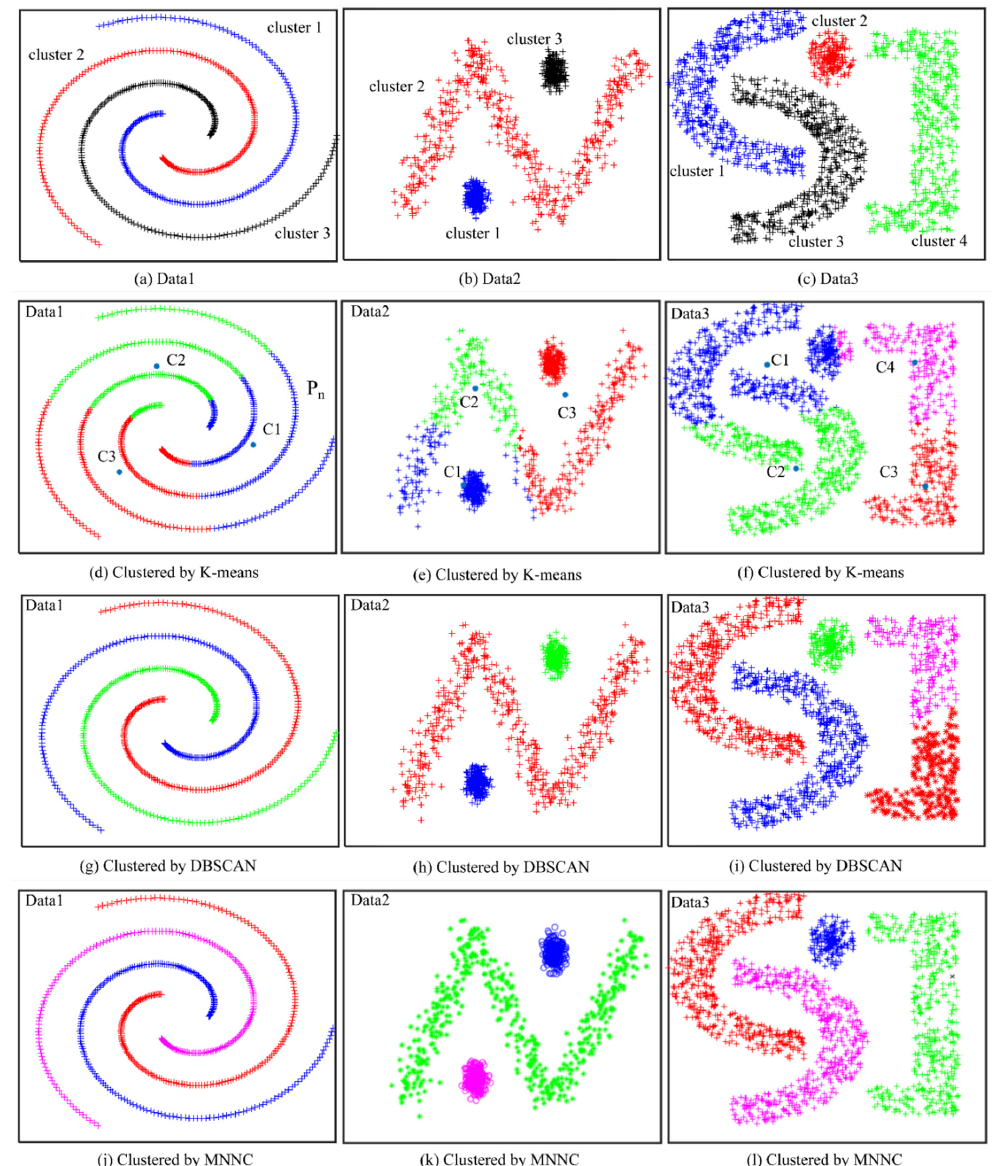
Figure 5. Clustering results of different clustering algorithms: ( a – c ) are the reference results; ( d – f ) are clustered by k-means; ( g – i ) are clustered by DBSCAN; ( j – l ) are clustered by MNNC. We generated three synthetic datasets called Data 1 (Figure 5a), Data 2 (Figure 5b), and Data 3 (Figure 5c) containing 600, 1001, and 1650 samples, respectively. Data 1